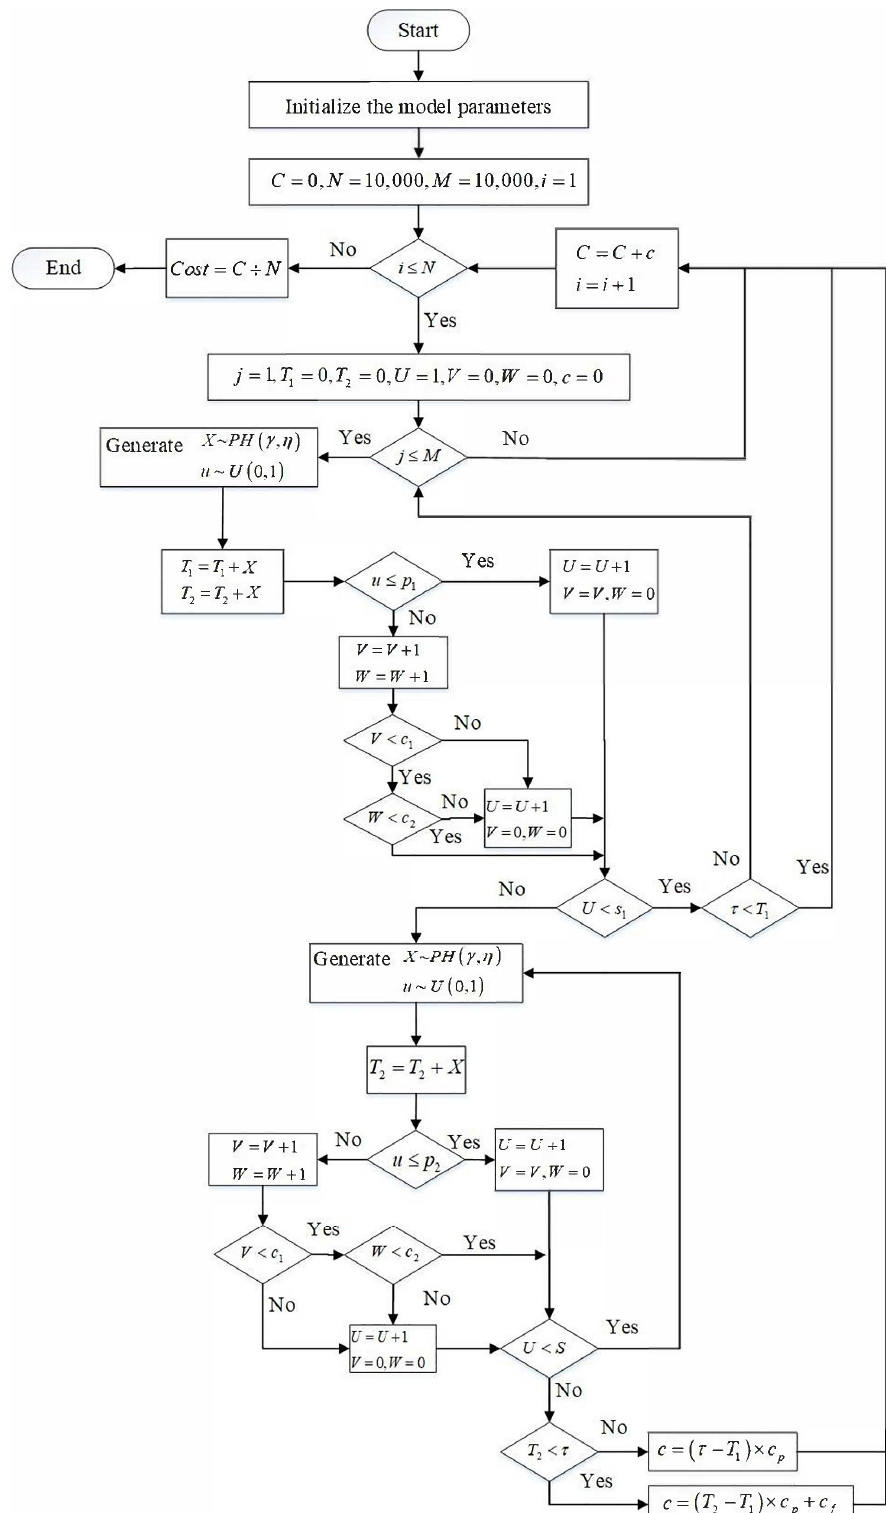
Figure 2. Flowchart of